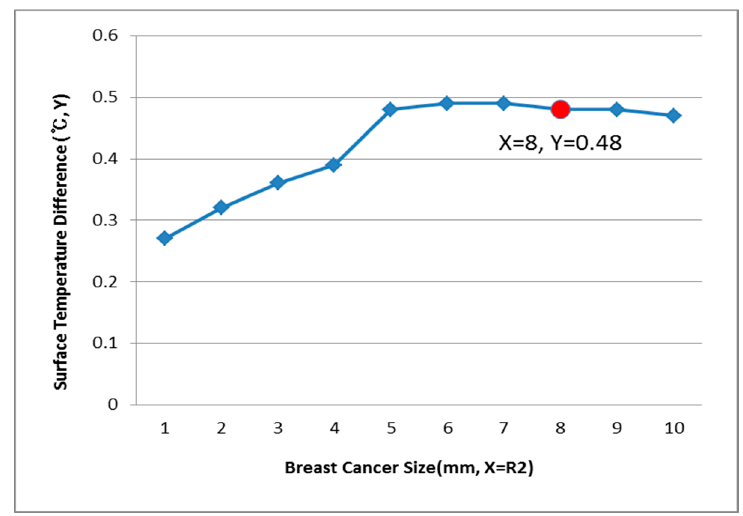
Figure 14. Surface temperature difference for an R1 of 80 mm (X = 10, Y = 10).